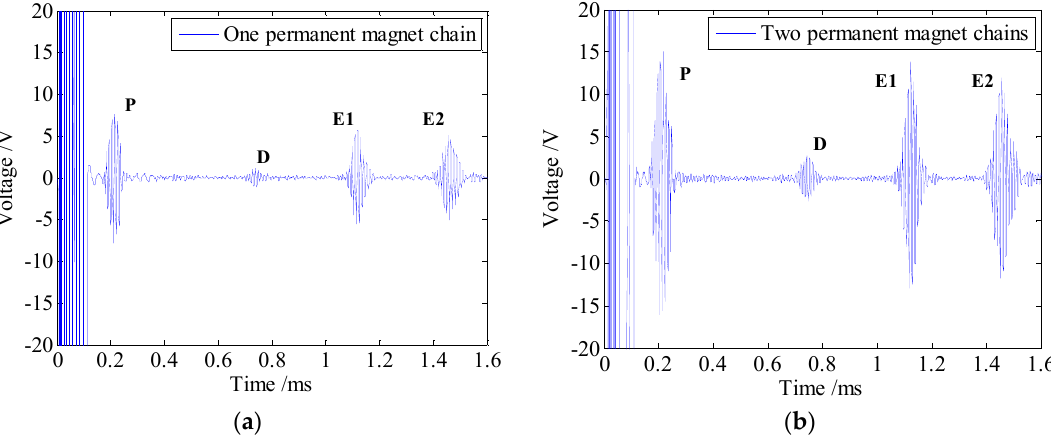
Figure 13. The testing signals received by the proposed EMATs with an average of 200 times ( a ) one permanent magnet chain ( b ) two permanent magnet chains.